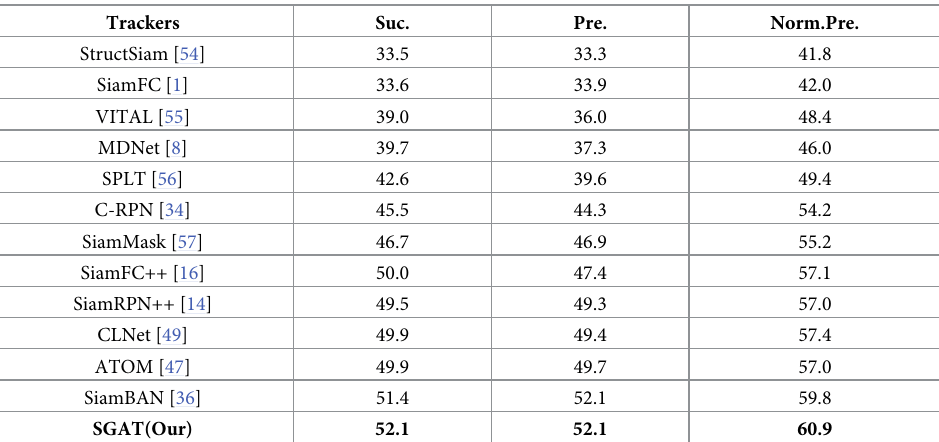
Table 3. A performance comparison with other competitive methods on the test split of LaSOT, where Suc., Pre. and Norm.Pre. represent the success rate, precision, normalized precision, respectively. Trackers Suc.